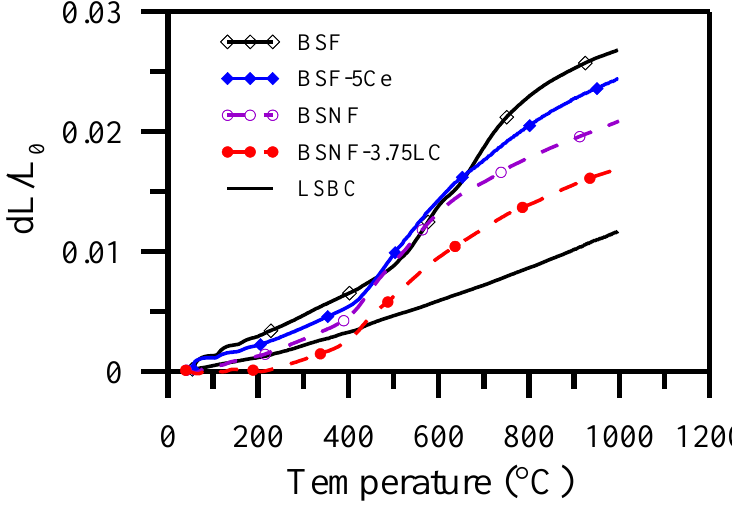
Figure 13. Comparisons of thermal expansion curves vs. temperatures for 1150 °C-6 h sintered BSF, BSF-5Ce, BSNF and BSNF-3.75LC; and 1500 °C-6 h sintered LSBC materials [72].